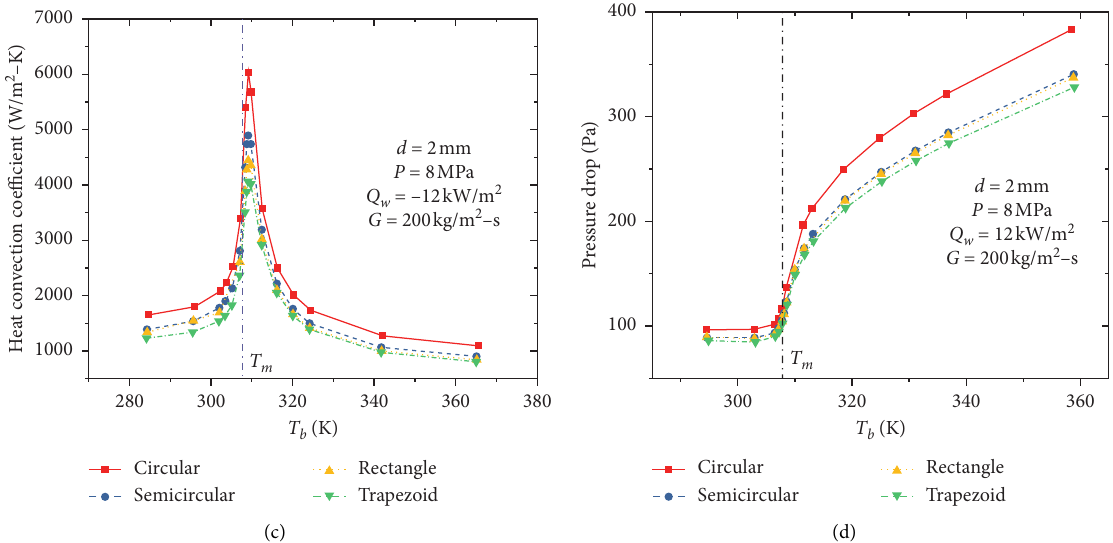
Figure 6: Heat convection coefficient and pressure drop results: (a) α of the heating case; (b) Δ P of the heating case; (c) α of the cooling case; and (d) Δ P of the cooling